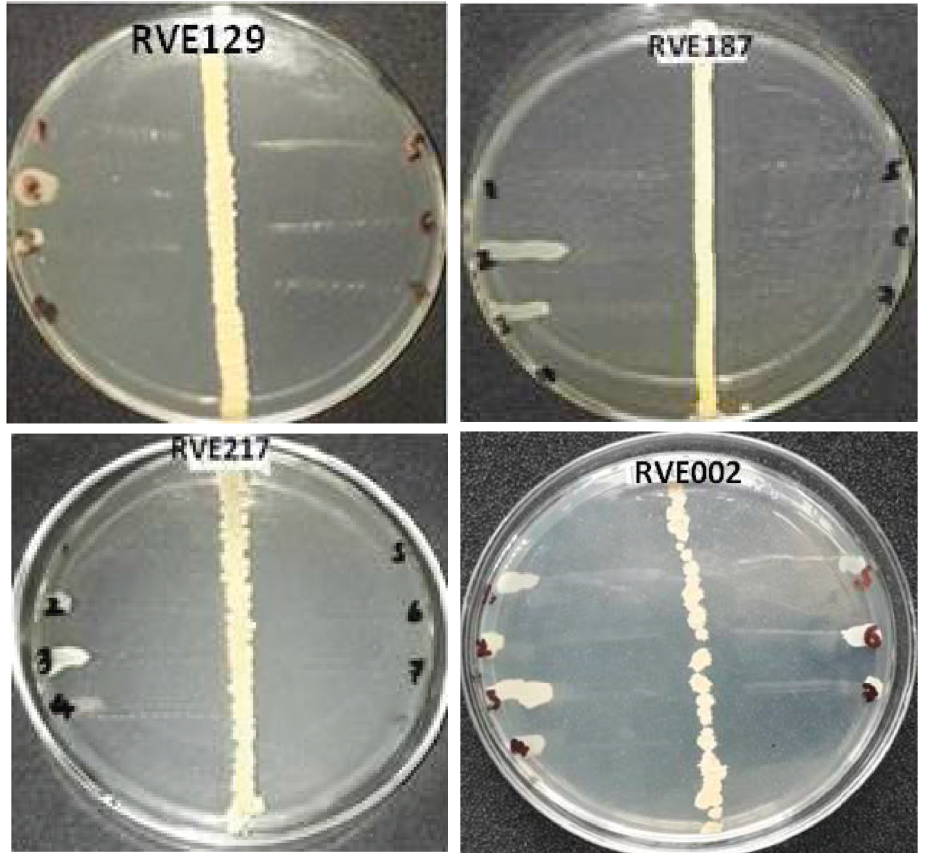
Figure 3: The inhibition zone of selected isolates against tested pathogens. The vertical streak is the actinomycete strains to be tested and the perpendicular streaks with numerical digits are the test organism Salmonella typhi ATCC-13311 (1), Pseudomonas aeruginosa ATCC-27853 (2), Klebsiella pneumoniae ATCC-700603 (3), Escherichia coli ATCC-25922 (4), Salmonella typhi ATCC-14028 (5), Staphylococcus aureus ATCC-259233 (6), and Staphylococcus epidermidis ATCC-12228